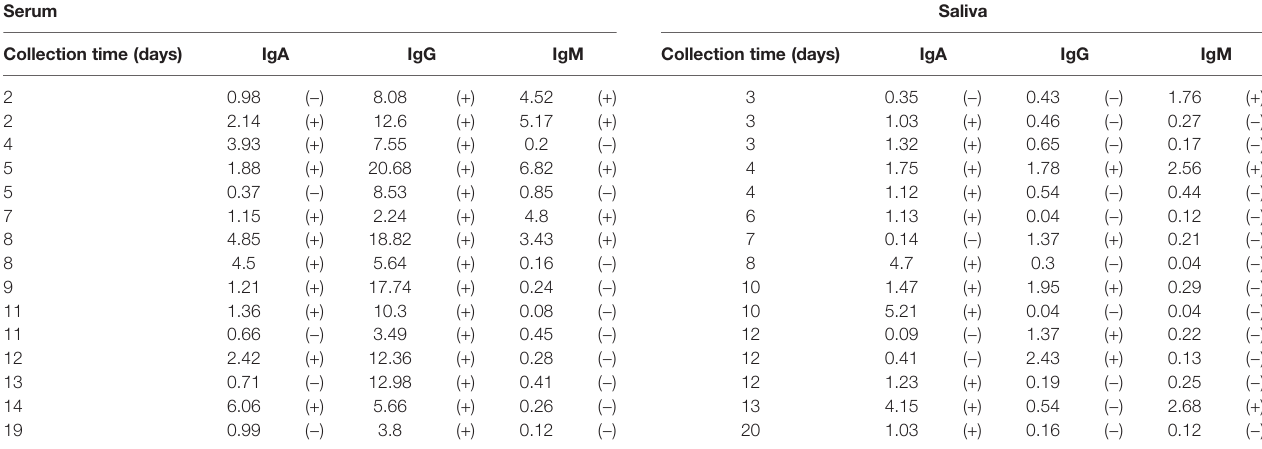
TABLE 3 | The collection time and results of paired serum and saliva specimens.